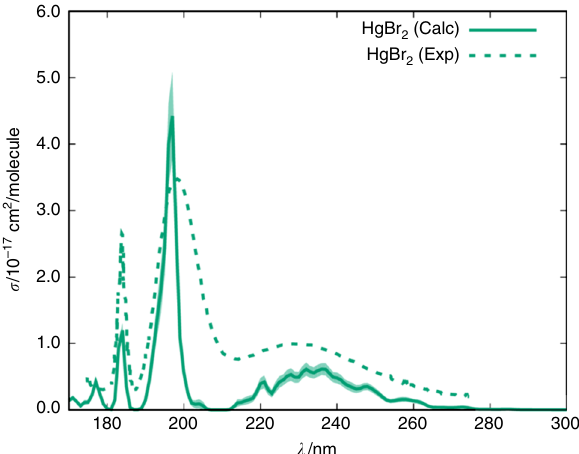
Fig. 3 Calculated and experimental cross section of gas-phase HgBr 2 . The calculated spectrum was obtained with the CASSCF/MS – CASPT2/SO RASSI methodological approach using the ANO-RCC-VTZP basis set. The light coloured areas correspond to the numerical error of absorption cross sections due to the statistical level quantum chemical computations 27 indicate that syn - HgBrONO is the most thermodynamically stable species.